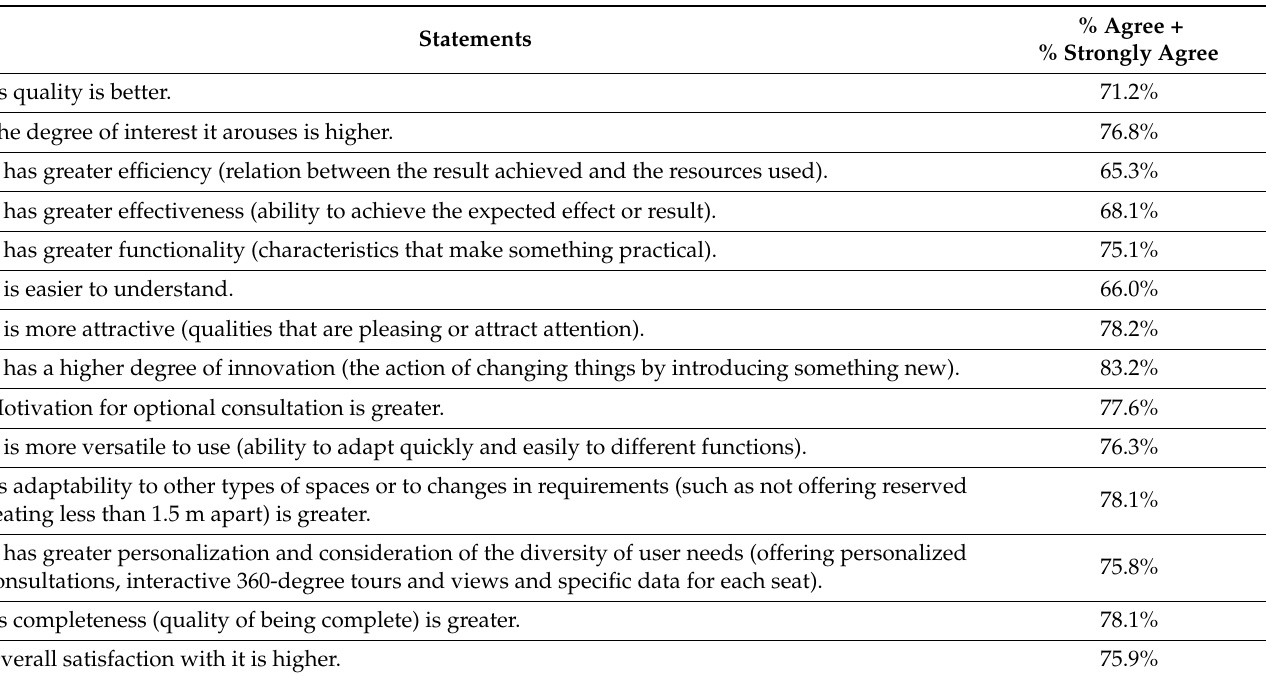
Table 5. Comparative assessment of Biblio-Smart compared with other reservation systems used.